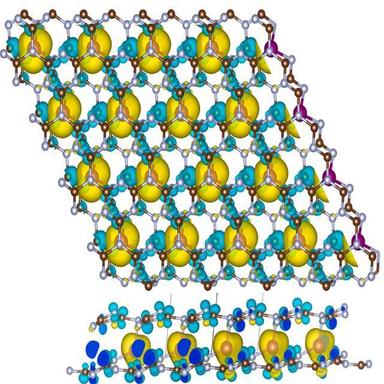
The spin density distribution of (Mn)@(g-CN1)2. Nitrogen atoms are depicted in grey, carbon atoms depicted in brown, manganese atoms are in purple. Spin-up density is depicted in yellow, spin-down density is indicated in cyan.